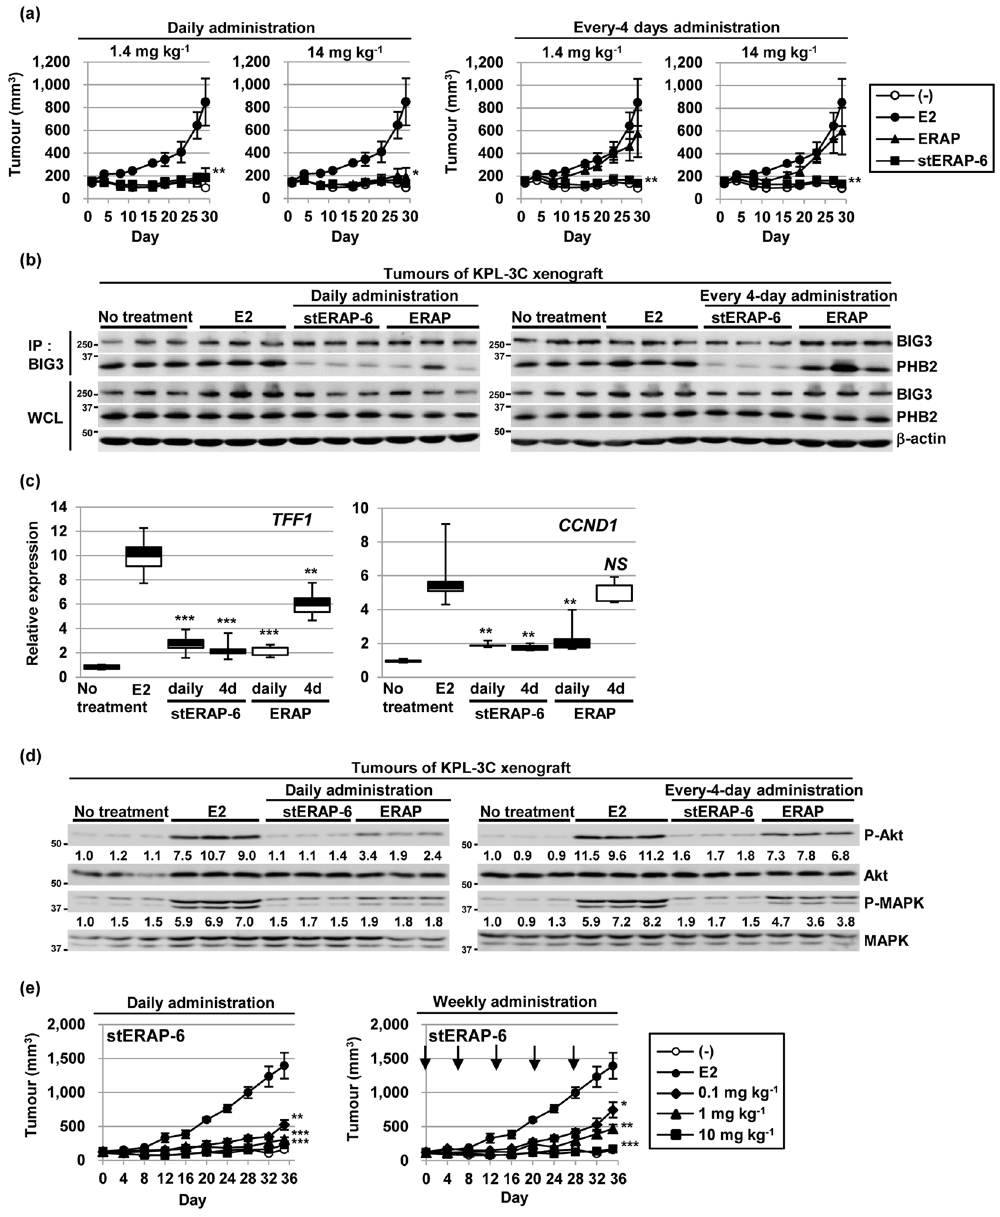
Figure 3. StERAP-6 has in vivo anti-tumour efficacy in xenograft models of human ER α -positive breast cancer. ( a ) Tumour growth assessed after daily (left) or every 4 days (right) intraperitoneal injection of 1.4 and 14 mg kg − 1 stERAP-6 or unstapled original ERAP (ERAP) in KPL-3C xenograft mice. The tumour sizes represent the mean ± s.e.m. of each group (n = 5). ( b ) Immunoblot analysis of the binding inhibition of the BIG3-PHB2 interaction in tumours treated intraperitoneally with daily (left) or every 4 days (right) of stERAP-6 or ERAP. ( c ) The inhibitory effects of stERAP-6 or ERAP on ER α -target genes expression in tumours treated for 28 days. The results were expressed as the fold increase over untreated tumours (set at 1.0). NS: no significance. The data represent the mean ± s.e.m. of five independent tumours. ( d ) Immunoblot analysis of the phosphorylation levels of Akt and MAPK in tumours treated intraperitoneally with daily (left) or every 4 days (right) of stERAP-6 or unstapled original (ERAP). ( e ) Tumour growth by intravenous injection of stERAP-6 daily (left) or weekly (right) in KPL-3C orthotropic breast cancer xenograft mice. The tumour sizes represent the mean ± s.e.m. of each group (n = 5). * P < 0.05, ** P < 0.01, and *** P < 0.001 via two-sided Student’s t